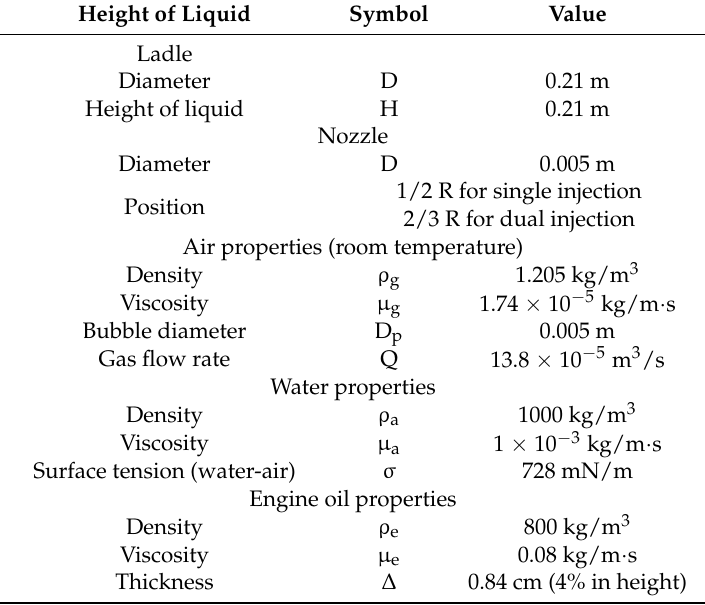
Table 2. Geometrical and physical variables in the physical model.